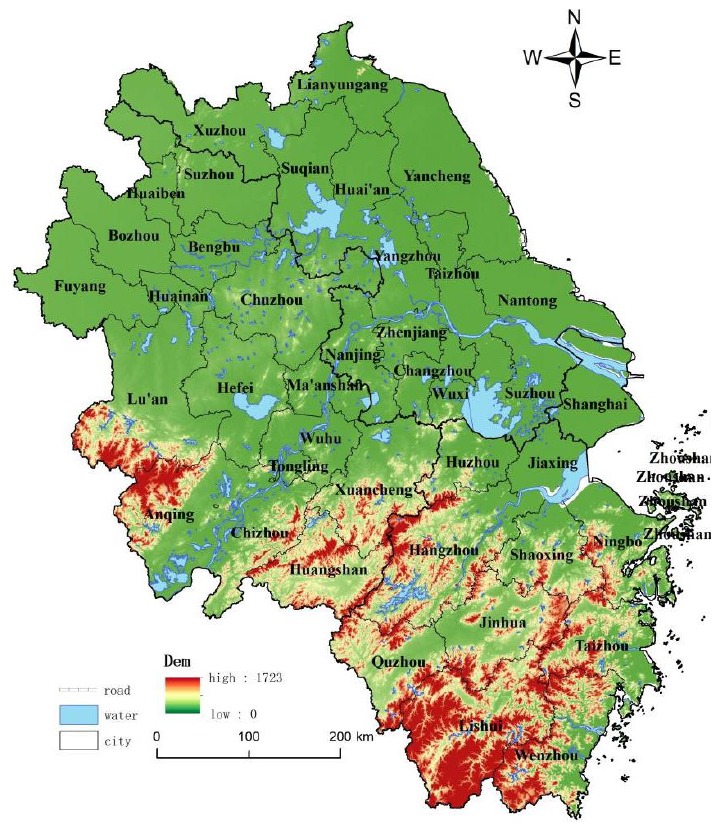
Figure 1. Study area.